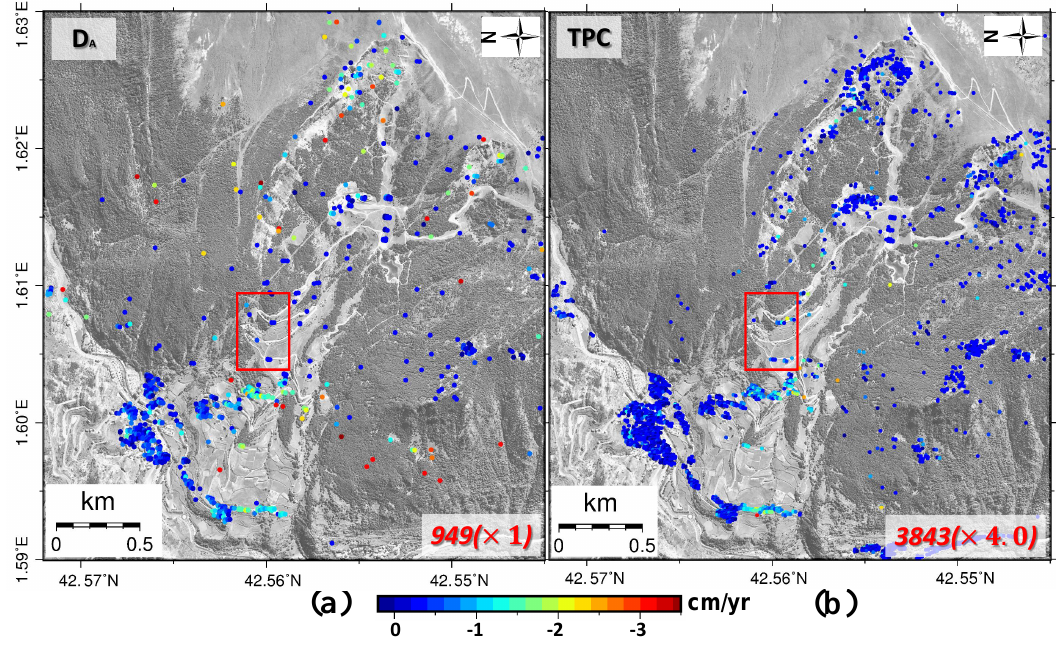
Figure 14. The LOS ground displacement velocity maps derived by ( a ) D A and ( b ) TPC methods with Sentinel-1A SAR